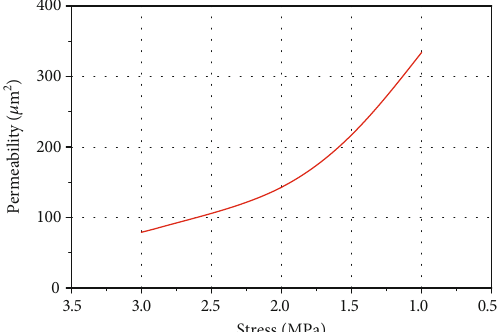
Figure 10: Change curve of permeability with con fi ning pressure for the coal specimen 2.